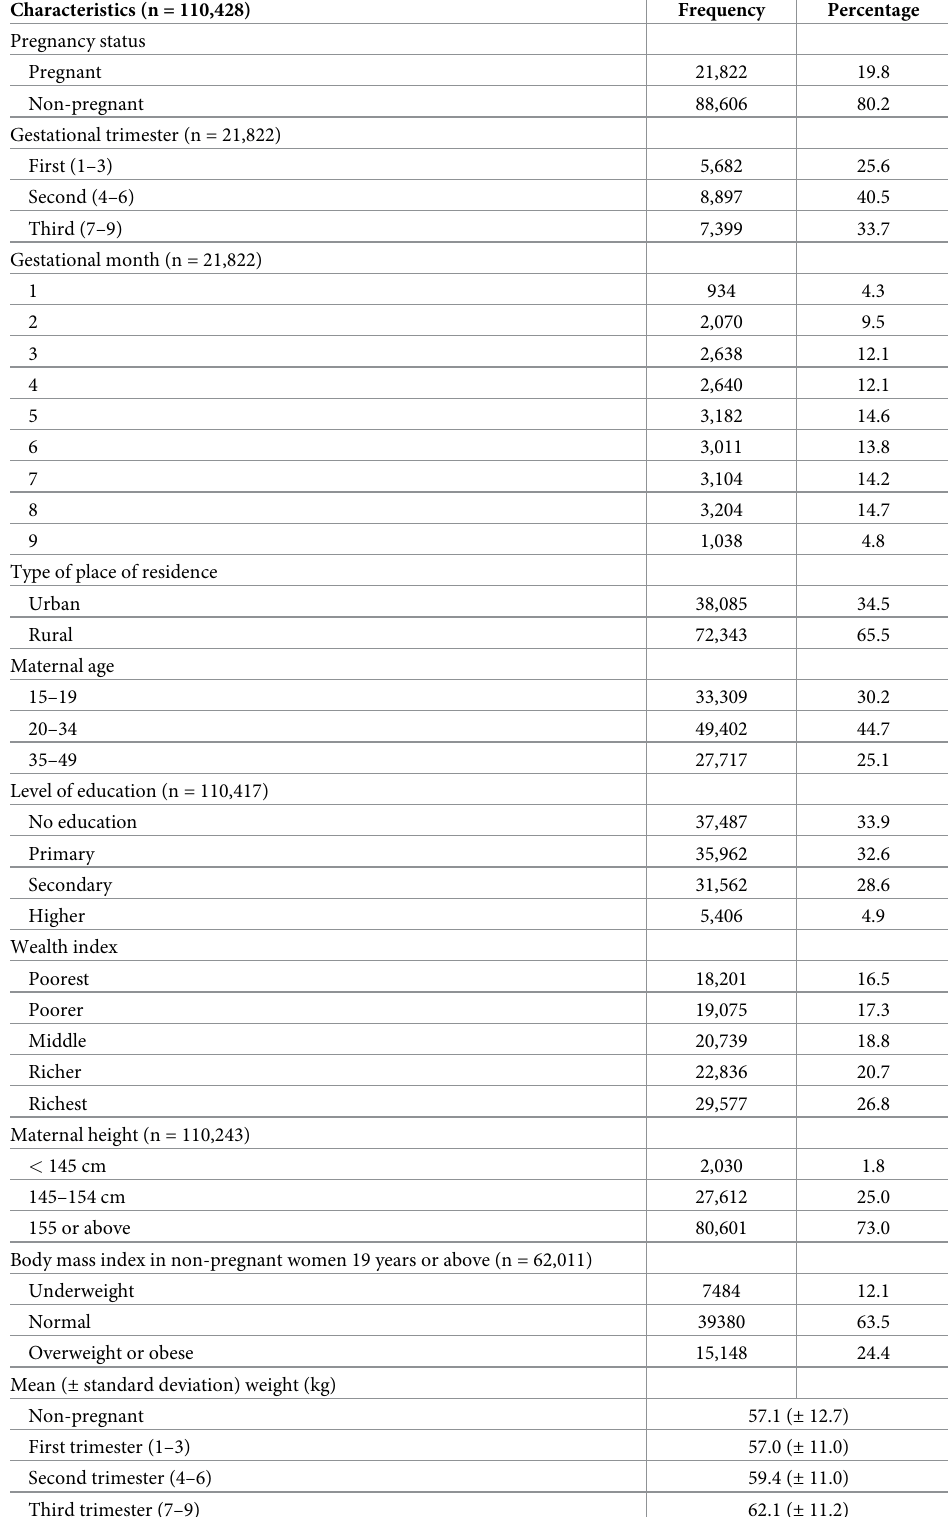
Table 2. Basic characteristics of the study subjects, sub-Saharan Africa,